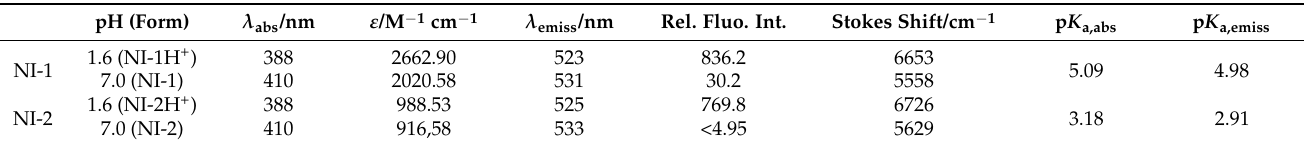
Table 1. Effect of pH on spectral properties of NI-1 and NI-2 in neutral and protonated/cationic forms at pH 1.6 and pH 7.0,